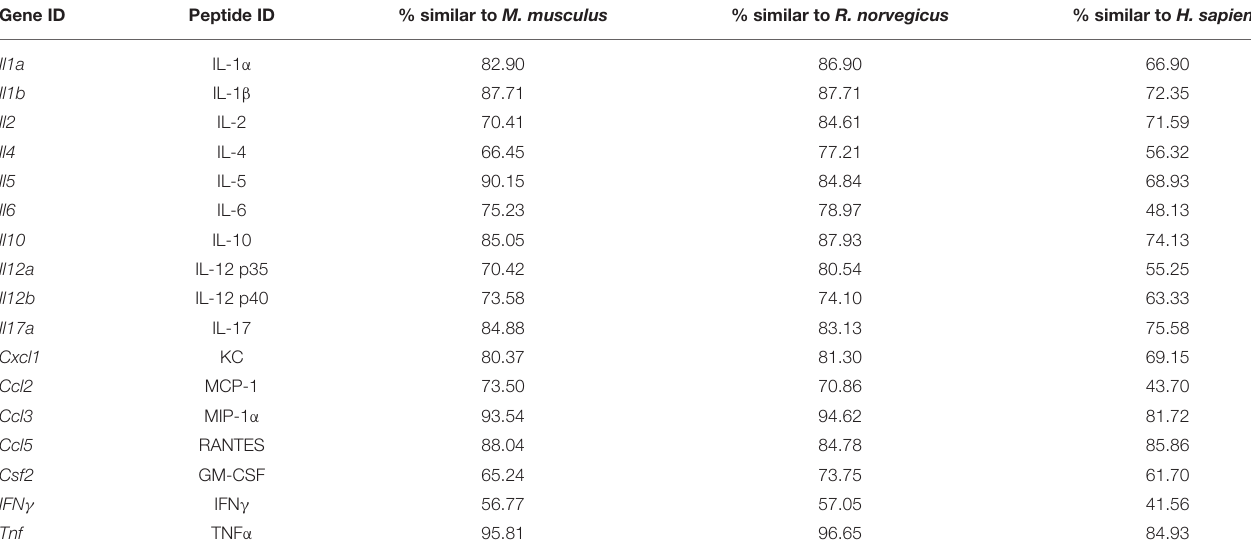
TABLE 2 | Comparison of A. cahirinus predicted peptide sequences used in cytokine analysis.